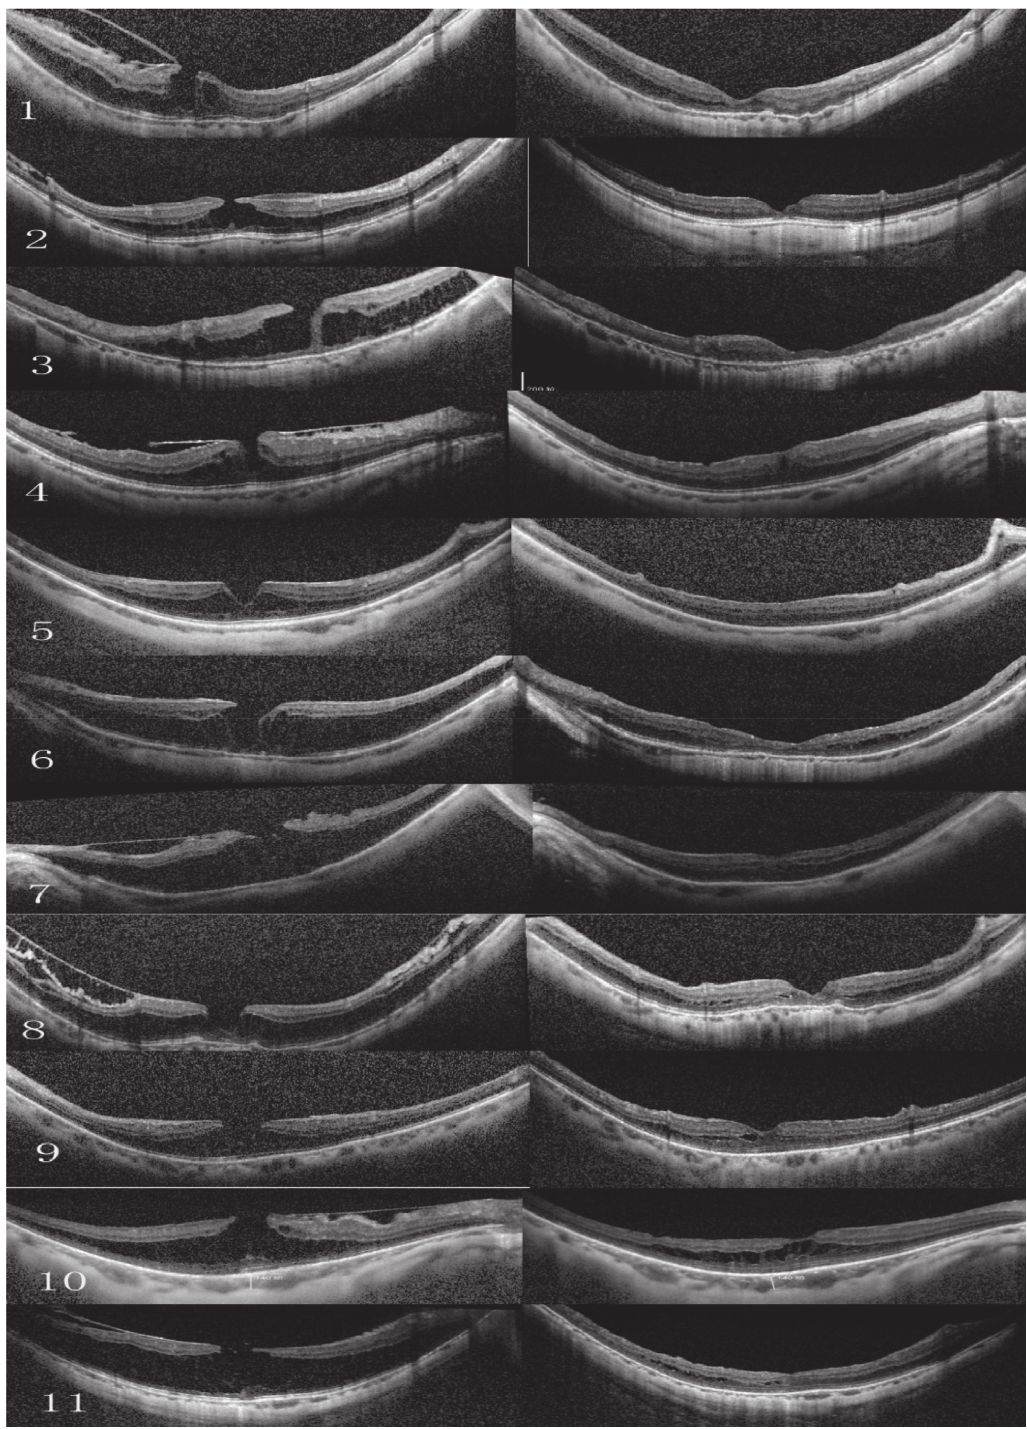
Figure 1: Preoperative and postoperative optical coherence tomography (OCT) scans for the 11 patients who underwent vitrectomy and suitable internal limiting membrane (ILM) peeling. The scans are shown as pairs (left, preoperative OCT; right, postoperative OCT) in chronological